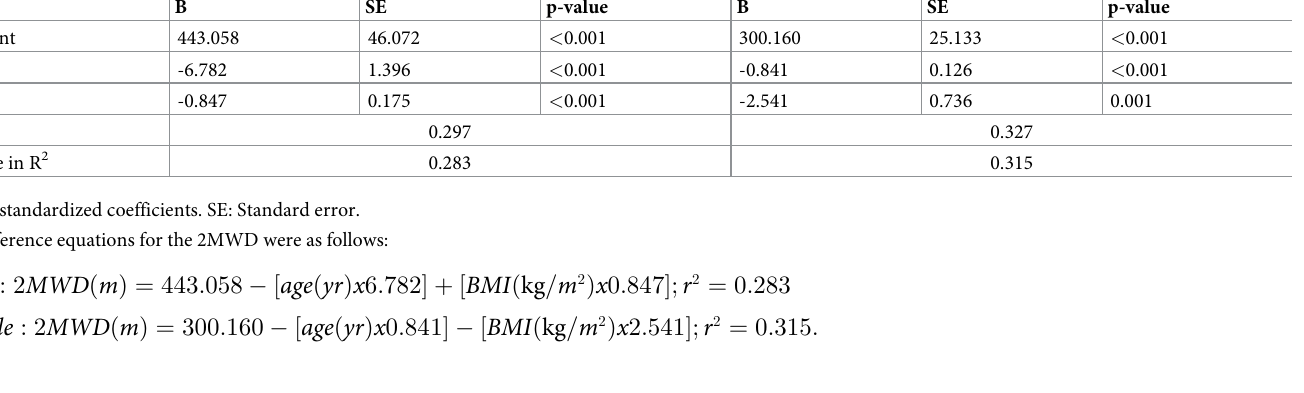
Among anthropometric parameters, age and BMI showed the highest correlation with 2MWD. According to the stepwise multivariate regression analysis, age and BMI were inde- pendently predictive of 2MWD among subjects of both sexes with obesity. After applying